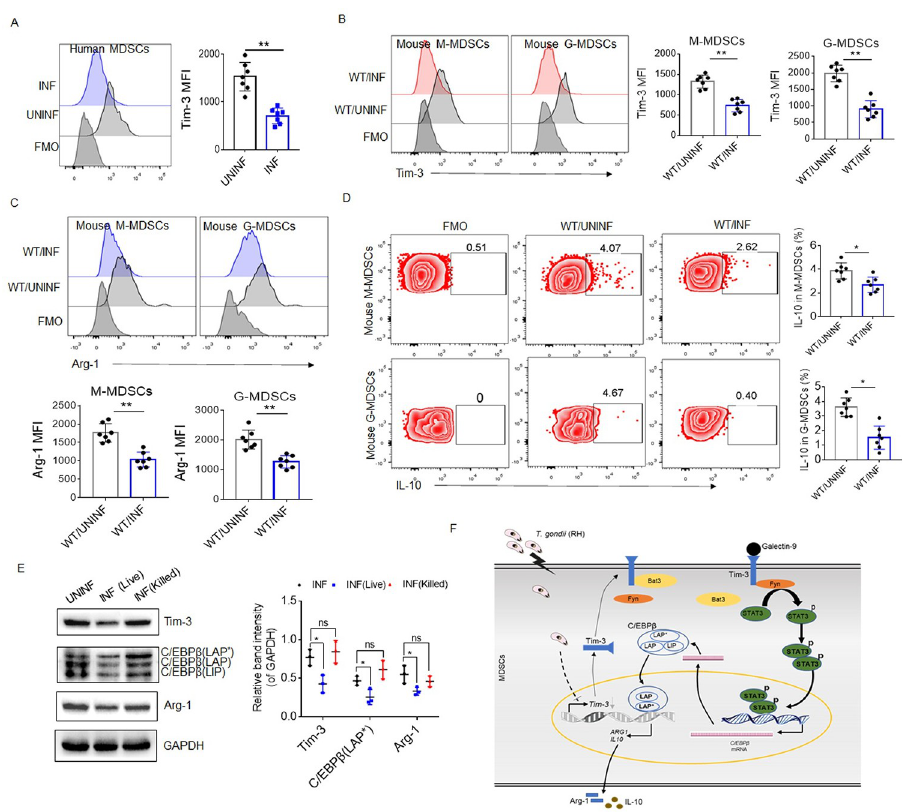
Fig 7. T . gondii infection inhibits Tim-3 expression in MDSCs. (A) Flow cytometry analyses of Tim-3 expression in human decidual MDSCs with (INF) or without (UNINF) T . gondii infection (n = 7). (B–D) Representative flow cytometry results and statistical analysis of the levels of Tim-3 (B), Arg-1 (C), and IL-10 (D) in decidual MDSCs from the uninfected WT (WT/UNINF) and infected WT (WT/INF) mice (n = 7). The data are presented as the mean ± SD of 7 mice, * p < 0.05, ** p < 0.01, Student’s t test. (E) Western blot analyses of Tim-3, C/EBP β , and Arg-1 expression in human decidual MDSCs infected with live T . gondii (INF (Live)), killed T . gondii by heat (IFN (Killed)), or without infection (UNINF). The quantified relative band intensity was determined by ImageJ. The results are shown as the mean ± SD of three separate experiments, One-way ANOVA, * p < 0.05. (G) Mechanism of how Tim-3 promotes the immunosuppressive function of MDSCs at the maternal-fetal interface. T . gondii infection inhibits the expression of Tim-3 in MDSCs. Moreover, Tim-3 signaling activated by its ligands such as galectin-9, may promote the activity of STAT3 by Fyn, then induce the expression and transcriptional activity of C/EBP β . As a transcription factor, C/EBP β upregulates the expression of Arg-1 and IL-10 and enhances MDSCs activation during T . gondii